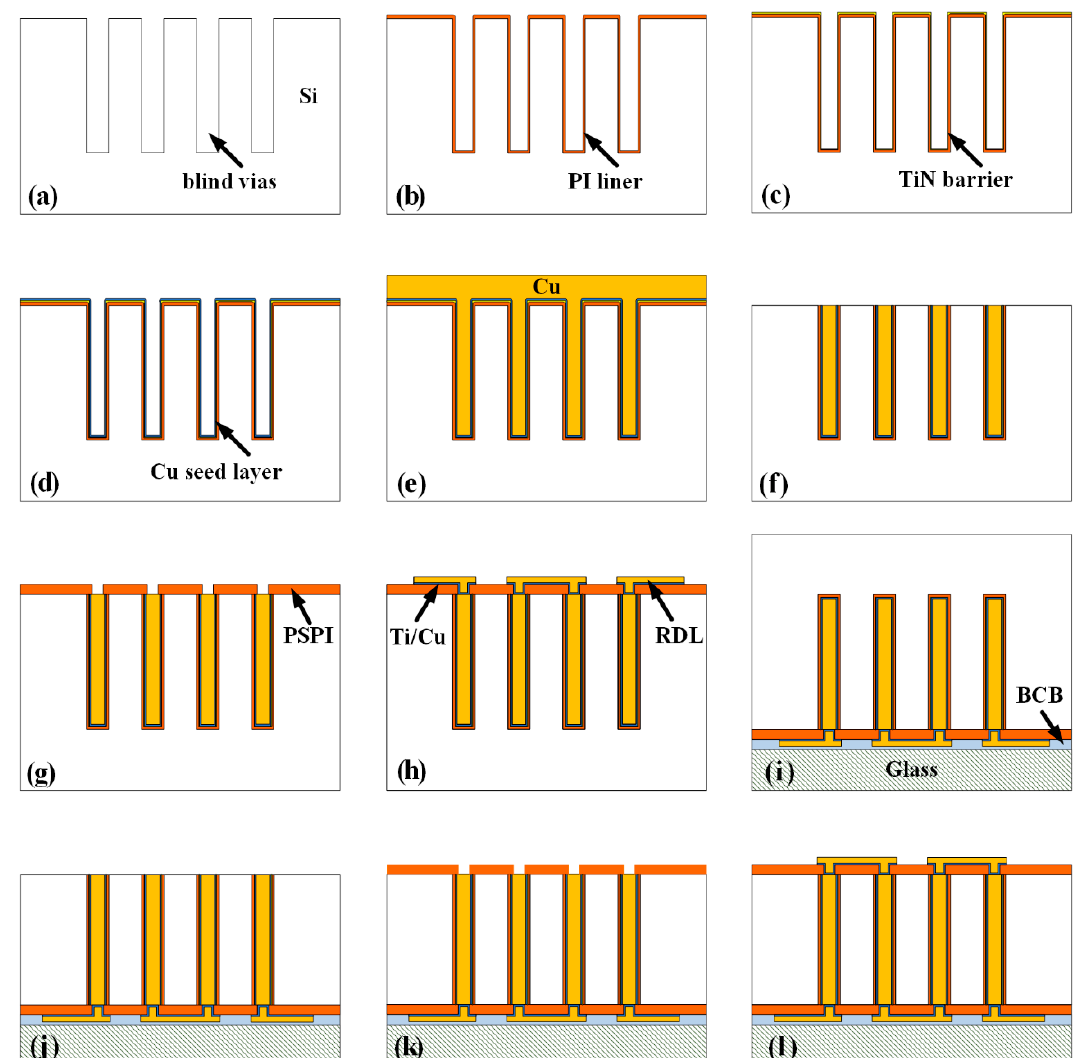
Figure 1. Schematic of the process flow for the HAR PI-TSVs: ( a ) Si DRIE, ( b ) vacuum-assisted spin coating of PI, ( c ) ALD of TiN, ( d ) sputtering and electroless plating of Cu seed layer, ( e ) Cu electroplating, ( f ) front-side CMP, ( g ) deposition of front-side PSPI insulating layer, ( h ) fabrication of front-side Cu RDLs, ( i ) permanent bonding, ( j ) back-side thinning and CMP, ( k ) deposition of back-side PSPI insulating layer, ( l ) fabrication of back-side Cu